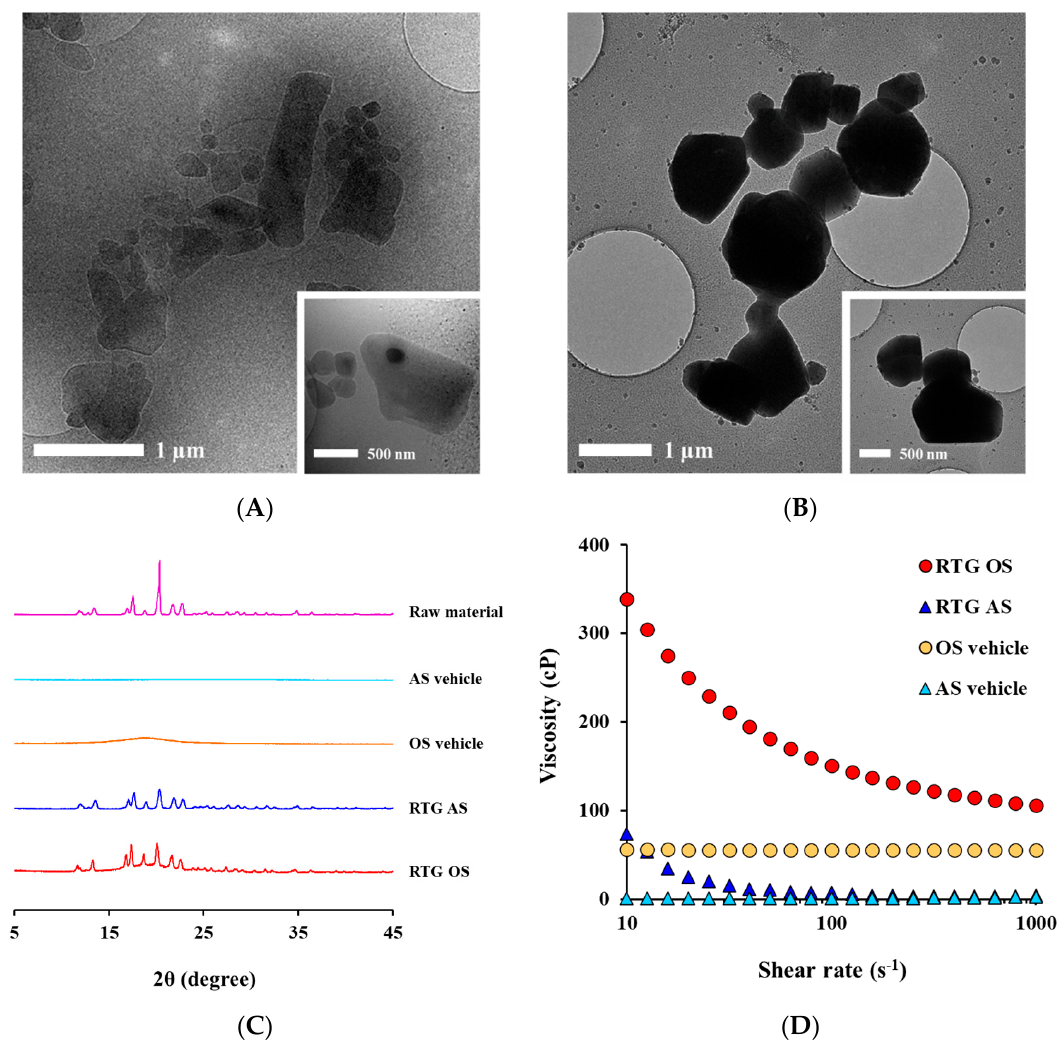
Figure 2. Morphological and physical features of RTG-loaded AS and OS systems. Transmission electron microscope (TEM) images of drug particles in ( A ) AS and ( B ) OS. ( C ) X-ray diffraction (XRD) patterns of the raw material, delivery vehicles, and injectable drug suspensions. ( D ) Apparent viscosity curve of RTG-loaded drug suspensions and delivery vehicles at a shear rate of 10–1000 s − 1 .